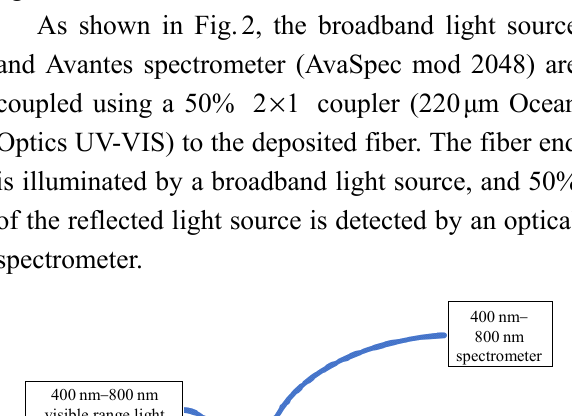
Fig. 4 J-aggregate spectral